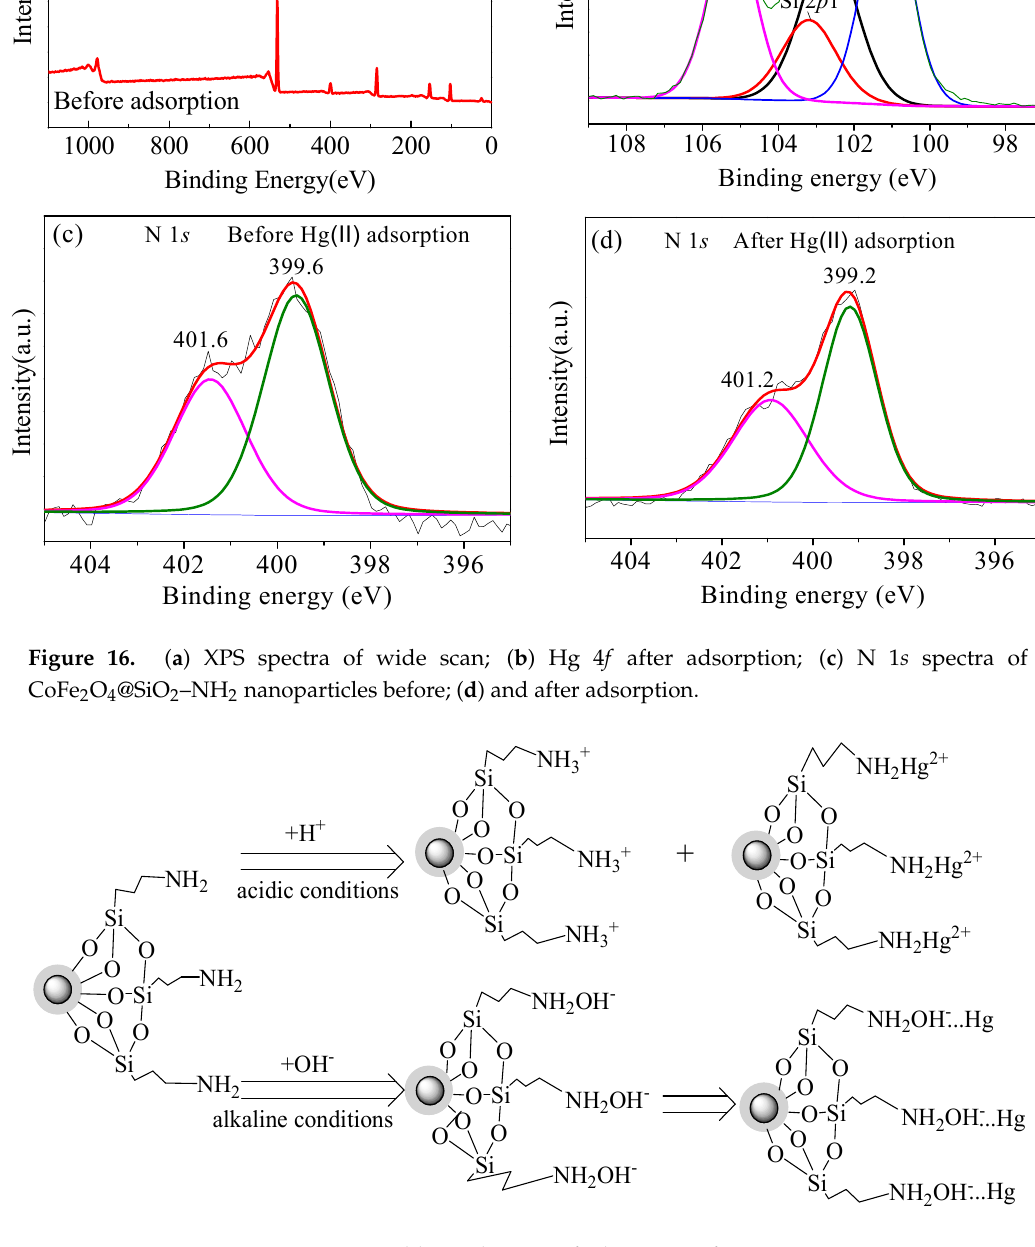
Figure 17. Possible mechanism of adsorption of mercury.